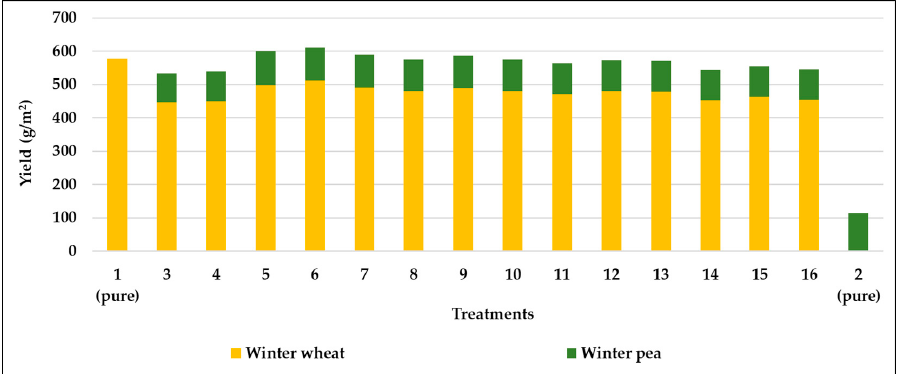
Figure 12. The total yield of winter wheat ( Triticum aestivum L.) and winter pea ( Pisum sativum L.) in different